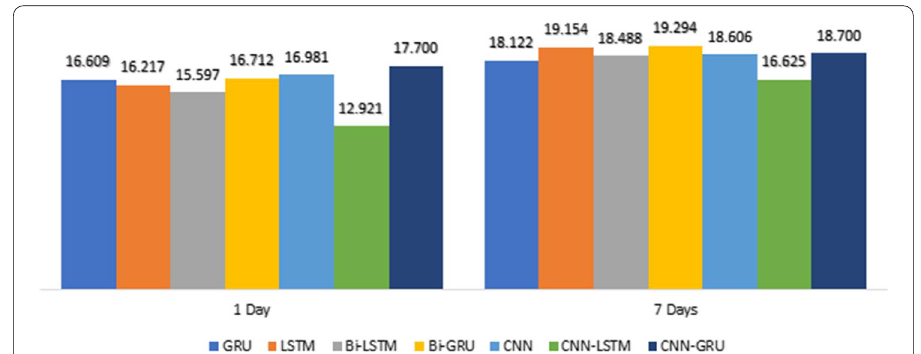
Fig. 14 Comparison of the RMSE for the 1day and 7day lag for the different deep learning models